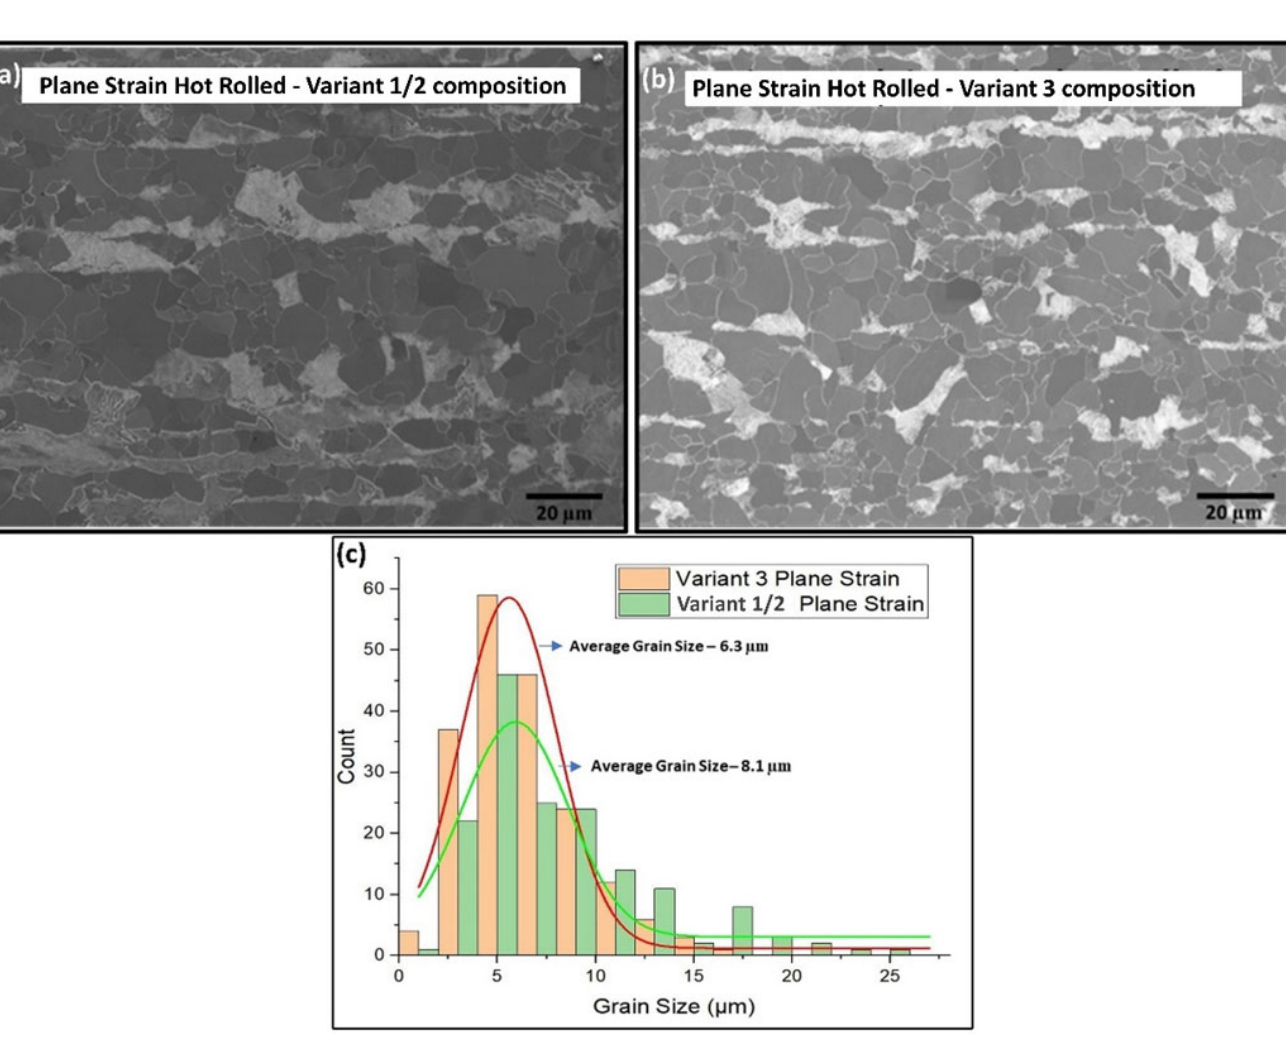
Figure 11. SEM microstructure for plane strain Gleeble HDS-V40 hot deformed: ( a ) Variant 1/2 com- position steel and ( b ) Variant 3 steel and ( c ) corresponding grain size distributions.